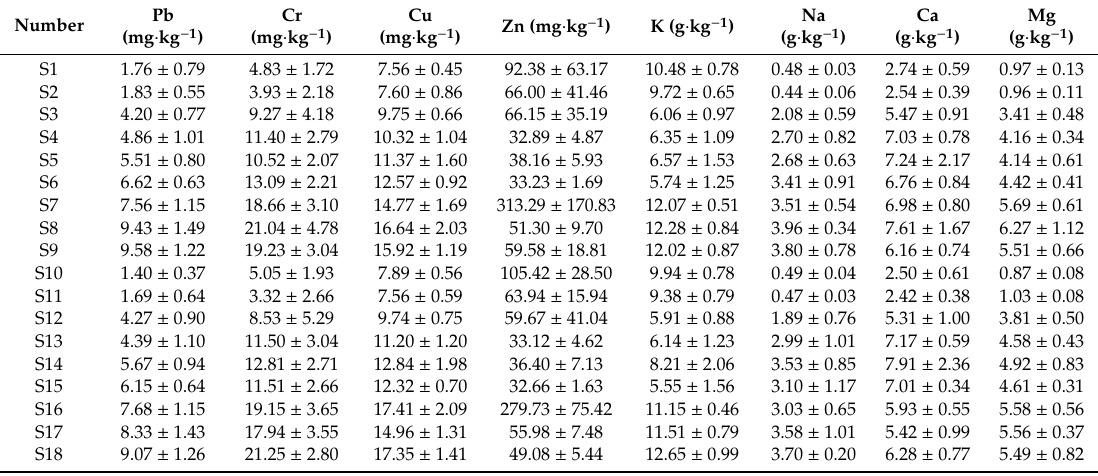
Table 6. Elemental content of major metals in standard samples.